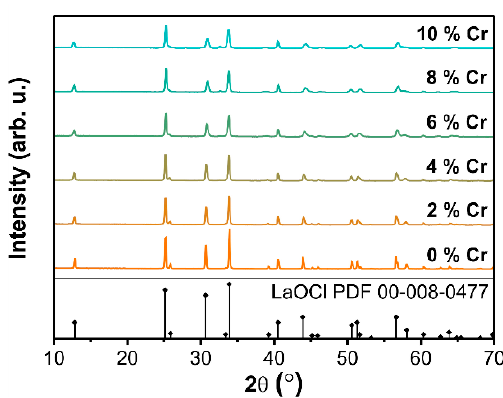
Figure 2. XRD patterns of LaOCl samples with different concentrations of Cr.